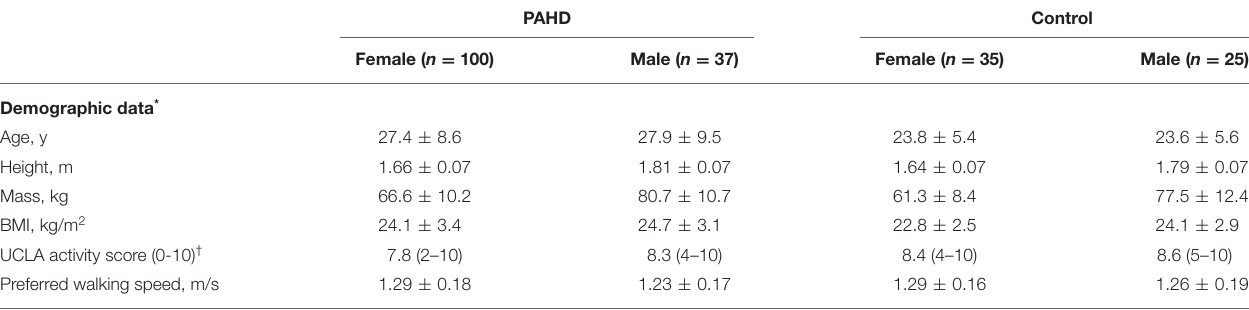
TABLE 1 | Participant